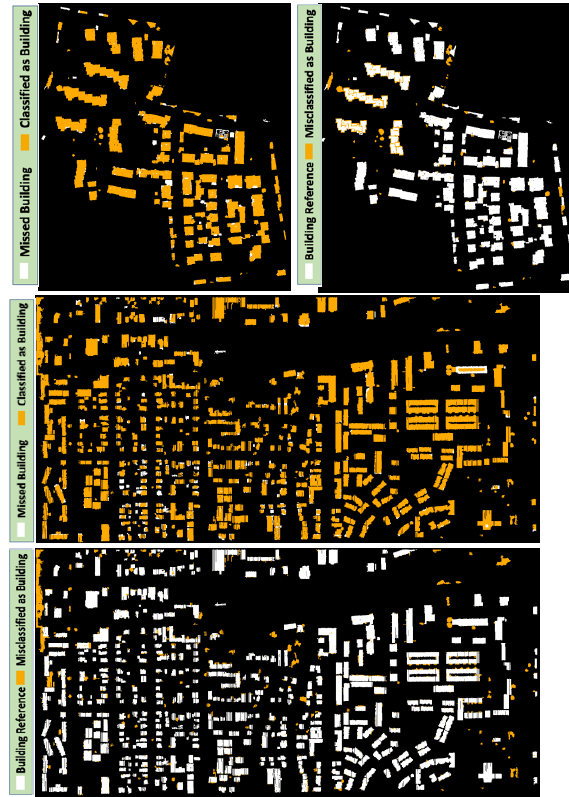
Figure 7. Building extraction results for Vaihingen (top) and Bloomington (middle &bottom) datasets with reference